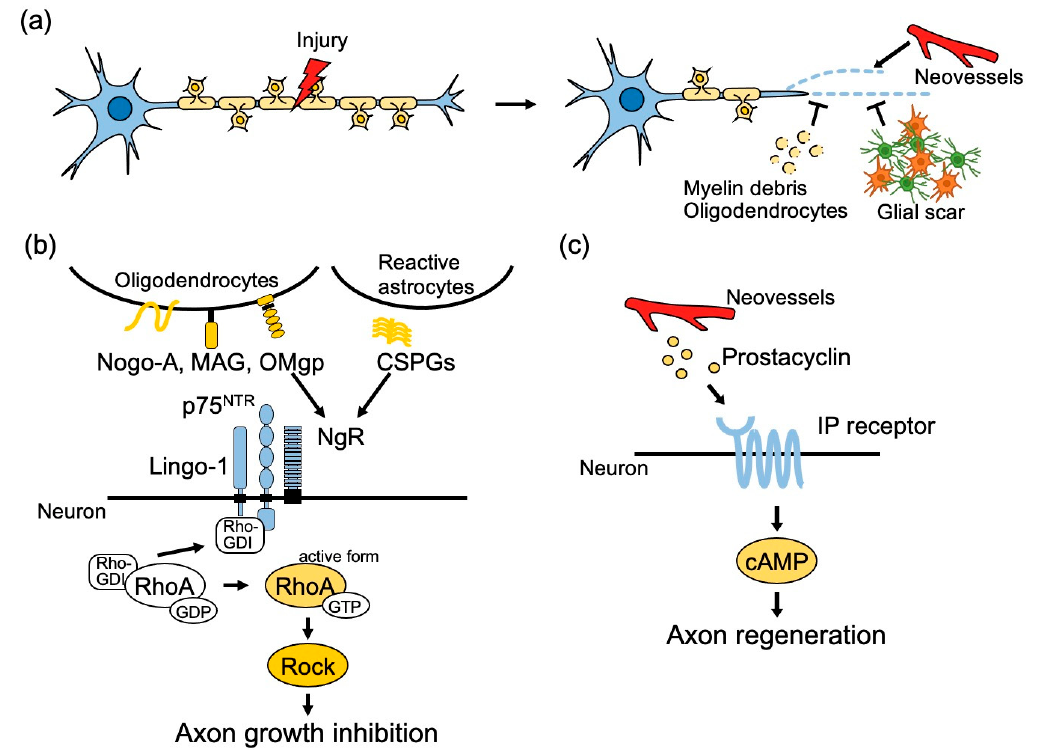
Figure 1. Molecular mechanisms underlying the microenvironmental regulation of axon regeneration in the adult central nervous system (CNS). ( a ) Illustration of the concept about inhibition of axon regeneration. ( b ) Myelin-associated glycoprotein (MAG), Nogo-A, and oligodendrocyte myelin glycoprotein (OMgp) expressed in oligodendrocytes and chondroitin sulfate proteoglycans (CSPGs) derived from reactive astrocytes around lesioned axons bind to Nogo receptor (NgR) / p75 NTR / Lingo-1 receptor complex expressed in neurons and activate RhoA to inhibit axon growth. ( c ) CNS inflammation induces axonal degeneration, and partial rewiring of axons is followed by neovessel formation. Prostacyclin derived from endothelial cells binds to I type prostaglandin (IP) receptor expressed in the neurons, stimulates cyclic adenosine monophosphate (cAMP), and promotes axon regeneration.